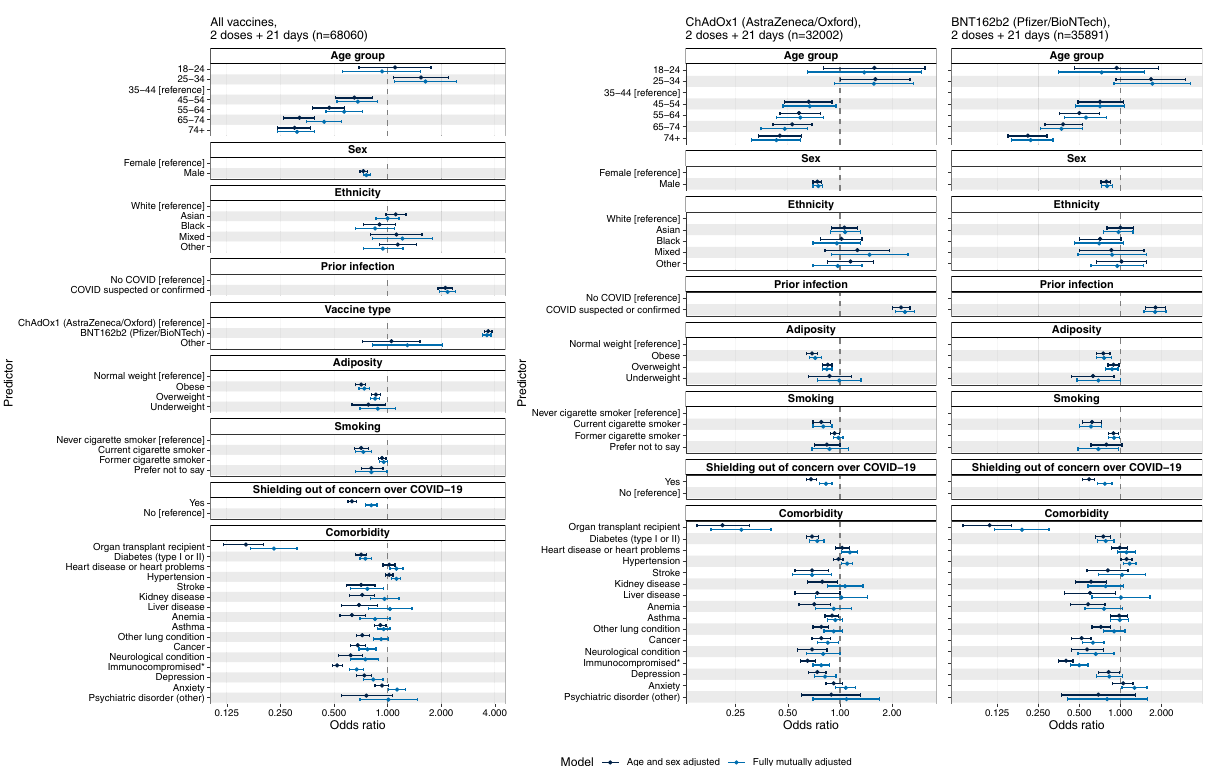
Fig. 2 Forest plot showing odds ratios and 95% con fi dence intervals for antibody positivity (yes/no) versus biological and behavioural covariates in logistic regression models, among 68,060 respondents who had received two vaccine doses with the second dose at least 21 days prior. Dark blue CIs indicate models adjusted on age and sex only; light blue CIs indicate models adjusted on age, sex, ethnicity, adiposity, vaccine type (in the right panels only), prior infection, shielding status, comorbidities and smoking